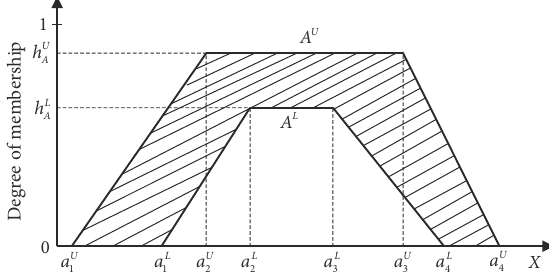
Fig. 1. A geometrical interpretation of an IT2TrF number A on